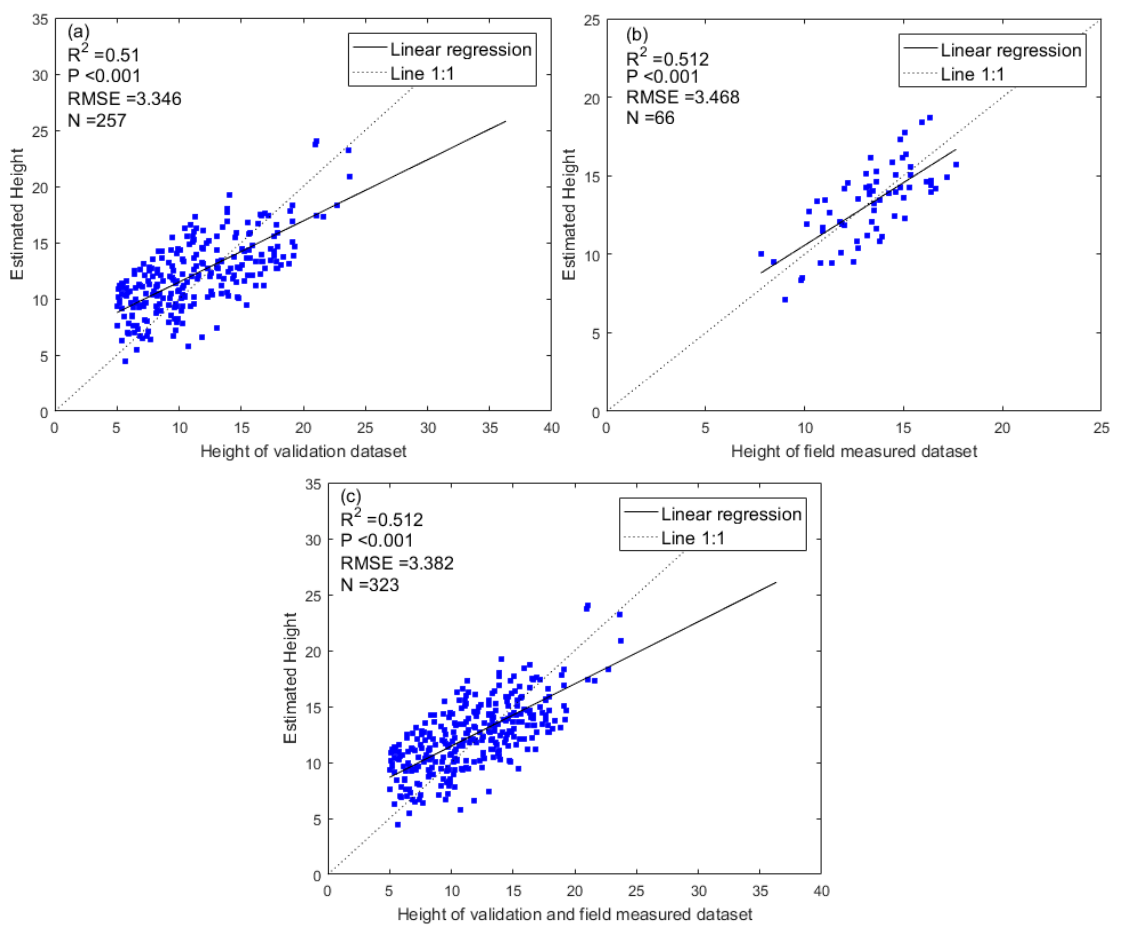
Figure 10. Forest canopy height estimated by the BP-ANN with training samples of the discontinuous CHM dataset.